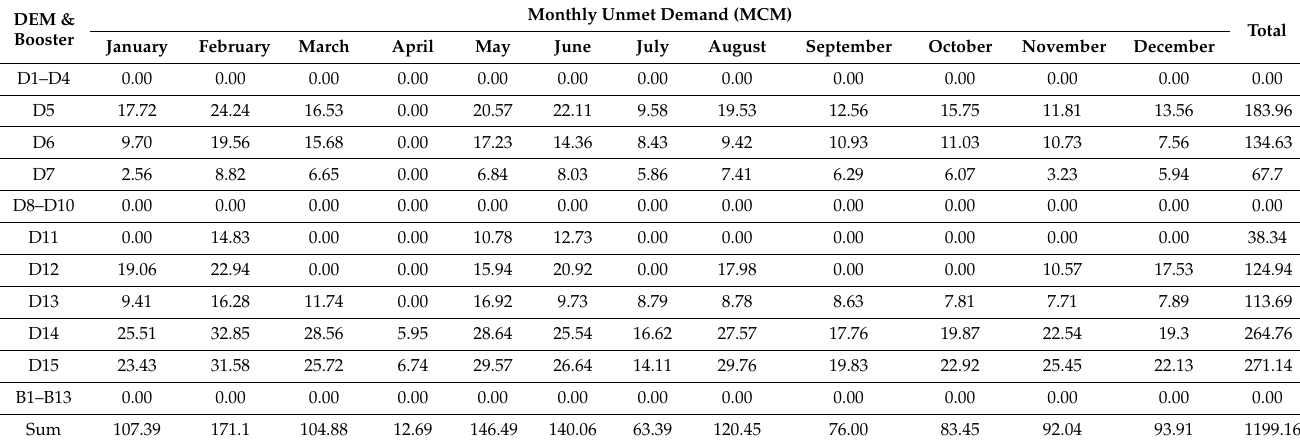
Figure 17. Monthly unmet demands (MCM) resulting from decrease in the Ismailia Canal head flow by 10%.